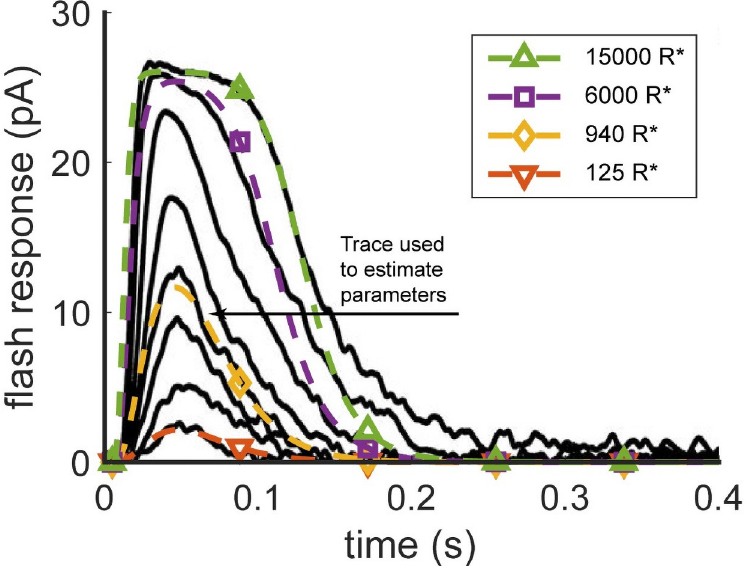
Fig 1. Modeling flash responses of a mouse cone. Black traces are flash responses recorded from a Gnat1 − / − mouse cone for an estimated range of 40—6,000 photoisomerizations with a half-maximal intensity that produced 940 photoisomerizations [45]. The colored traces show model predictions for indicated flash intensities. All simulations use the single set of parameters in Table 10. This set was found by stochastically minimizing the rms error between the model and experimental response solely for the 940-photoisomerizations trace while constraining the parameter values to satisfy known experimental constraints.